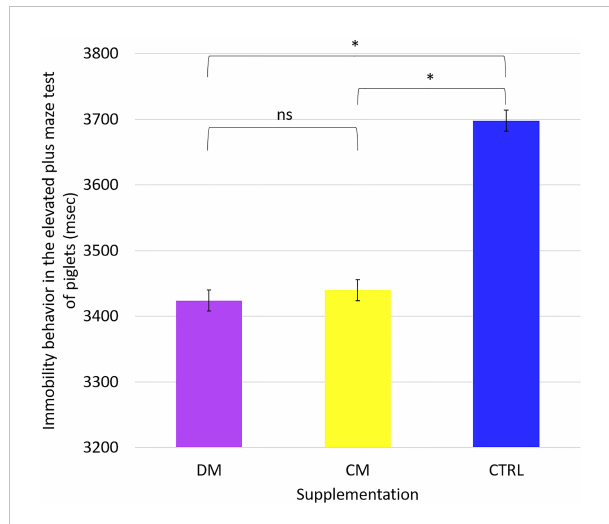
FIGURE 8 Immobility behavior in the Elevated plus maze tests of piglets (n = 48) supplemented DM (Asinine milk), CM (Cow skimmed milk) and CTRL (Control without supplementation) during the period from 25 to 31 days of life. Statistical description: ns (not signi fi cant, p > 0.05); * (signi fi cant, p < 0.05) by Fisher ’ s test.